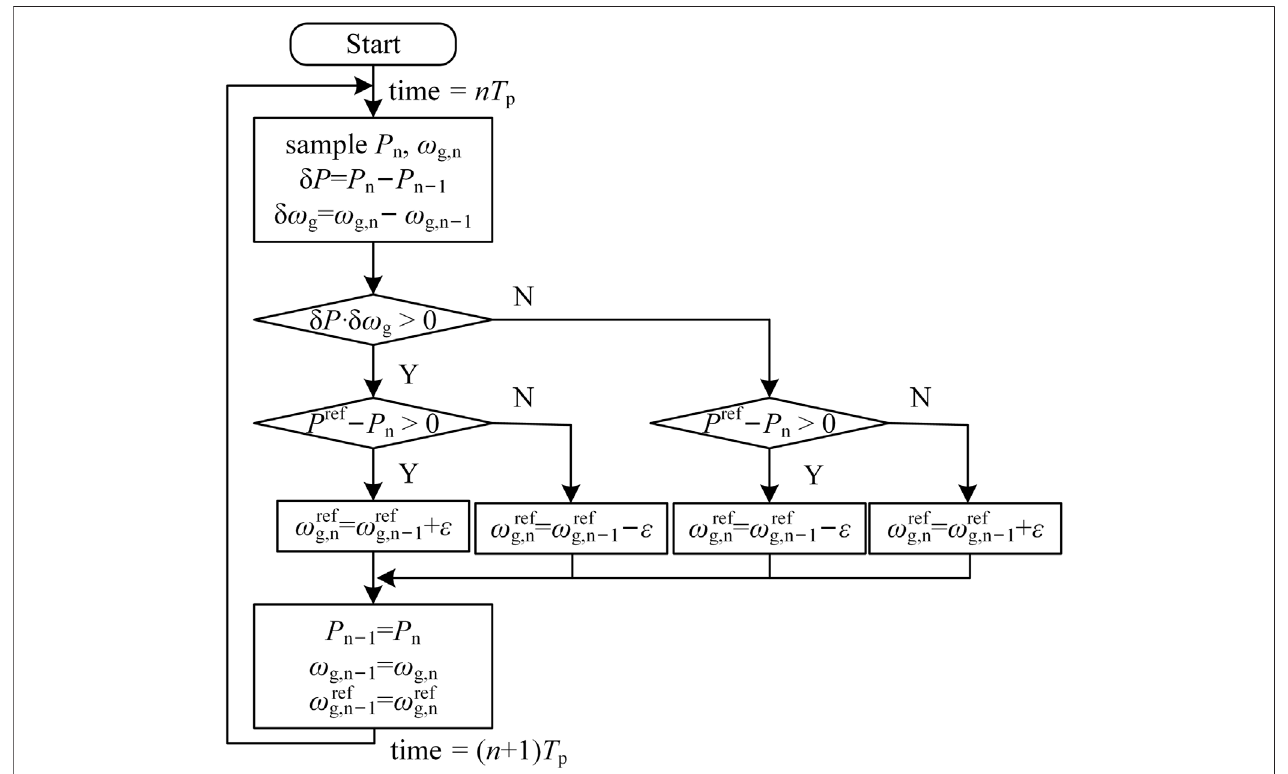
FIGURE 4 | Flowchart of a typical P&O